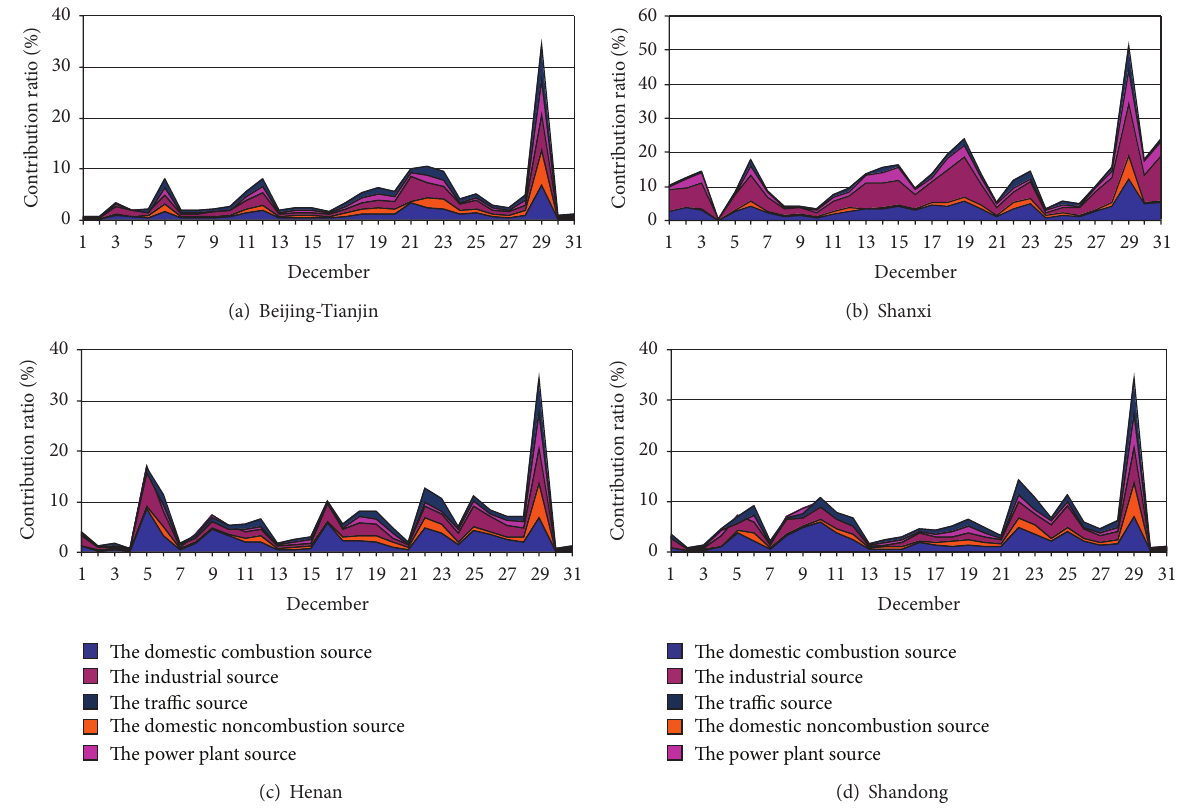
Figure 7: Contribution ratios of daily average PM 2.5 concentration from sector sources of the surrounding areas to Xingtai in December